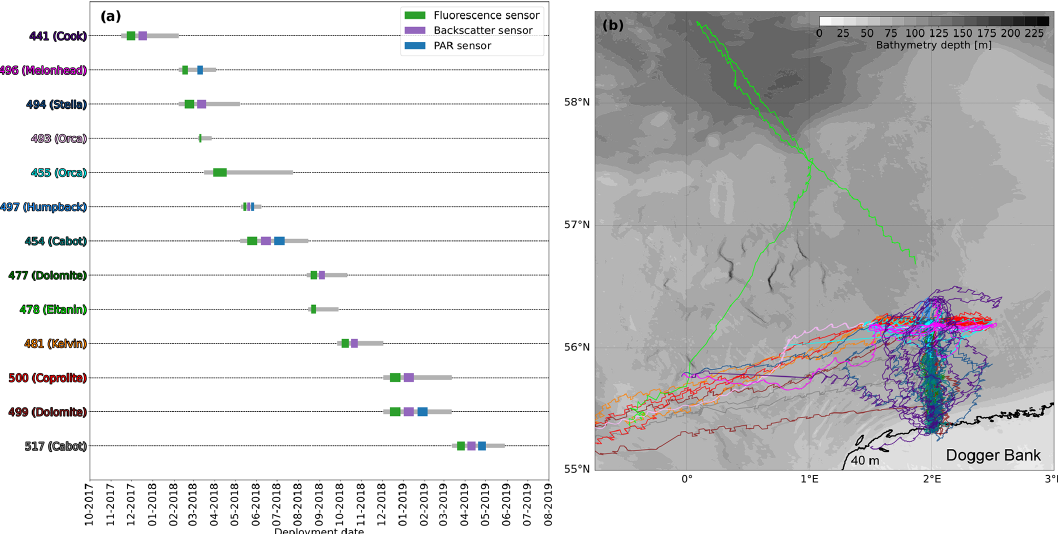
Figure 1. (a) Overview of the AlterEco glider deployment schedule and sensor payloads relevant to primary production calculations. (b) Tra- jectories of glider deployments overlaid on the General Bathymetric Chart of the Oceans (GEBCO) 2021 15arcsec bathymetry for the North Sea. Track colours match the respectively coloured glider name from panel (a) (and with Fig. 9), with warmer track colours corresponding to later deployments. The 40m contour, shown in black, nominally represents the outer edges of Dogger